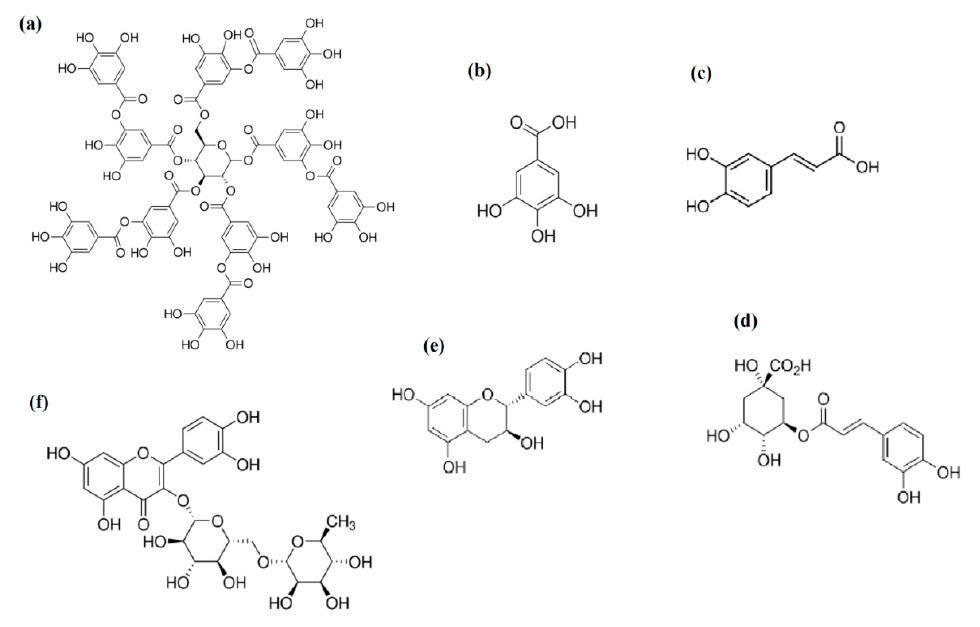
Figure 7. Chemical structures of identified phenolic compounds in PR varieties extracts; ( a ) tannic acid; ( b ) gallic acid; ( c ) caffeic acid; ( d ) chlorogenic acid; ( e ) catechin; ( f ) rutin.